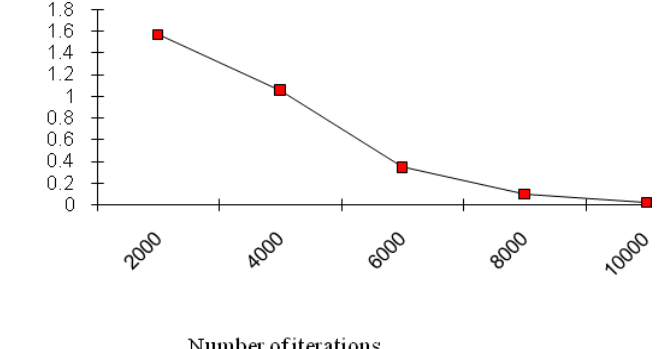
Figure 5. Total MSE for number of iterations in the